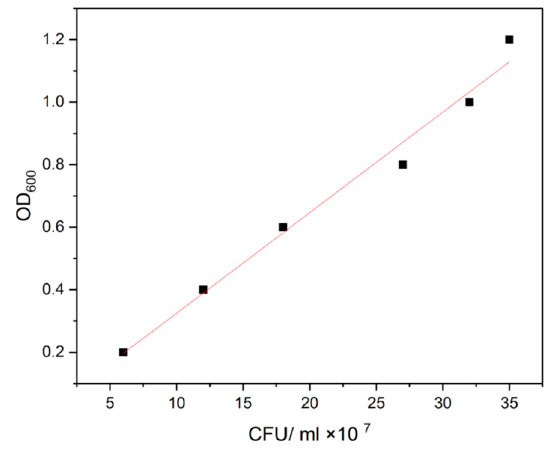
Figure 1. Standard curve of Aeromonas hydrophila to determine the concentration of bacterin uptaken by Artemia nauplii (R 2 = 0.98875; y = 0.3848x − 0.0805).